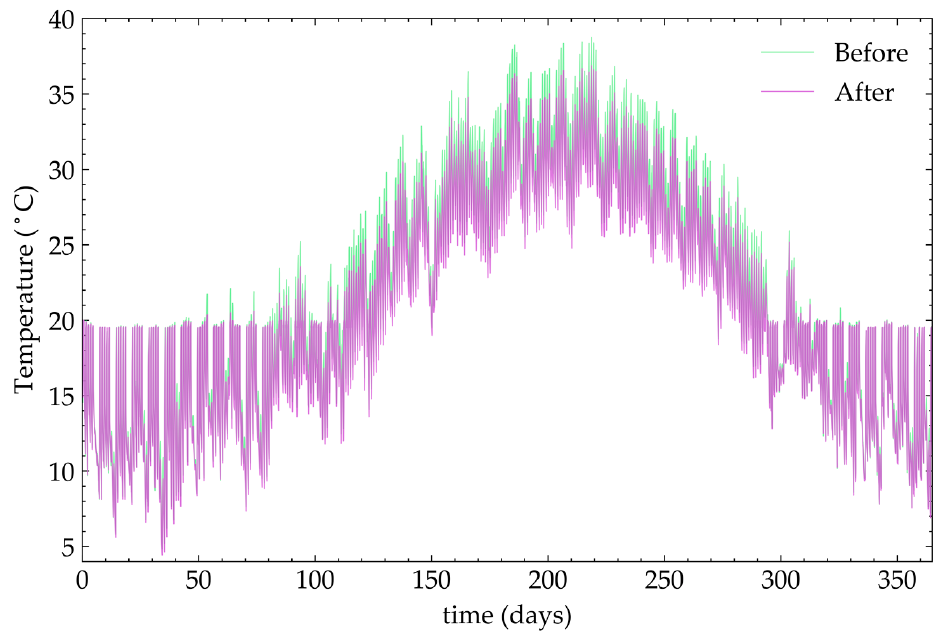
Figure 11. The Greek pilot room temperature (in ◦ C) before/after the